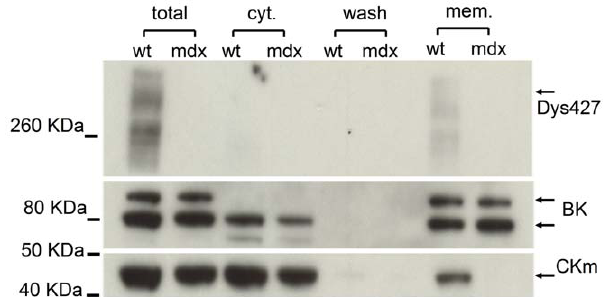
Figure 8. Dystrophin is required for the membrane cellular localization of CKm. mdx and wt whole heart crude lysates were fractionated into the membrane (mem) and cytosolic fraction (cyt) and analyzed by western analysis with antibodies specific for dystrophin (top panel), BK (middle panel) and CKm (bottom panel). Note the presence of CKm in the membrane fraction of only the wt lysate while BK, which was used as a control, is present in both the wt and the mdx samples. The partial degradation for Dys427 is due to the extraction without detergent, required for the membrane separation. Multiple BK bands are due to different glycosylation state of the protein during synthesis.